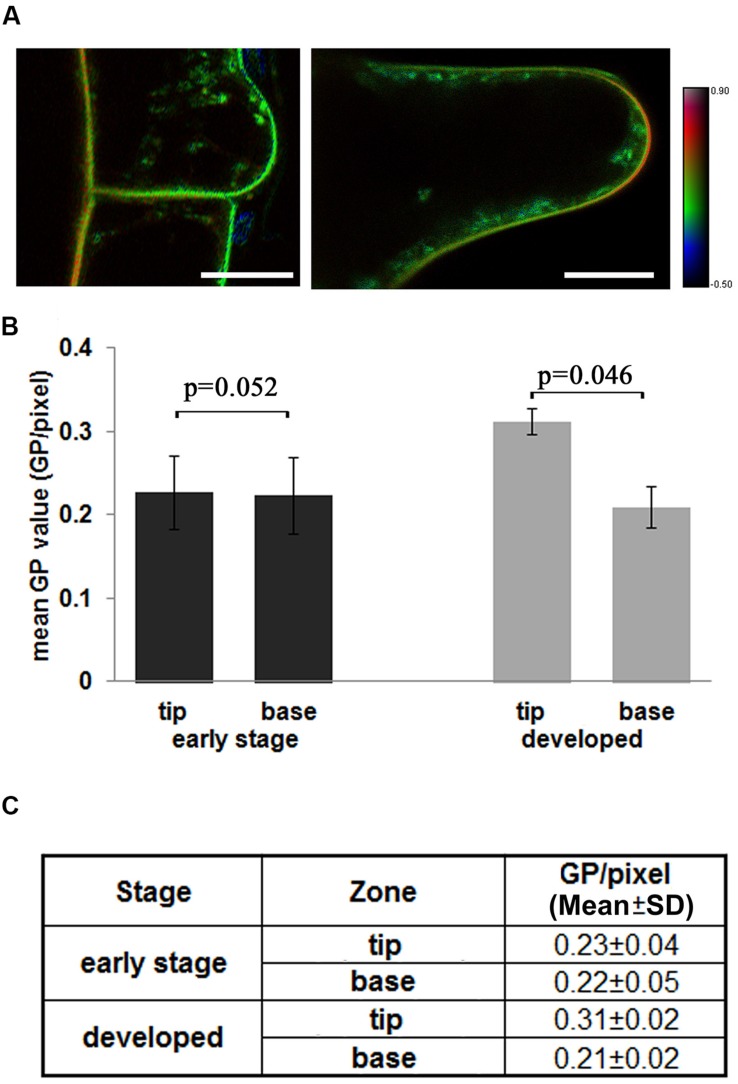
Distribution of the lipid order in the tip region of growing root hairs. (A) The 4-day-old Arabidopsis seedlings were stained with Di-4-ANEPPDHQ. Dual-channel images were taken using CLSM as longitudinal optical sections, GP images were calculated, and the lipid order were shown in HSB images. Left: a root hair in an early development stage, right: a developing root hair. The color bar indicates the lipid order. The scale bar is 25 μm. (B) Different distributions of GP values in early root hairs and developed root hairs. In the initiation stage hairs (<10 μm), whole hair region was measure as tip region, attached epidermal cell was measure as base region. In the tip growing hairs (10–50 μm), the tip region (10 μm from tip) and base region (rest part of hairs) were measured and mean values calculated. (C) Mean GP values (GP per pixcel) and standard deviation in different regions. Statistical significance between the cortical and epidermal layers, according to the Mann–Whitney u-test. (n = 30, significant difference: p < 0.05; no significant difference: p > 0.05; p-values were presented).